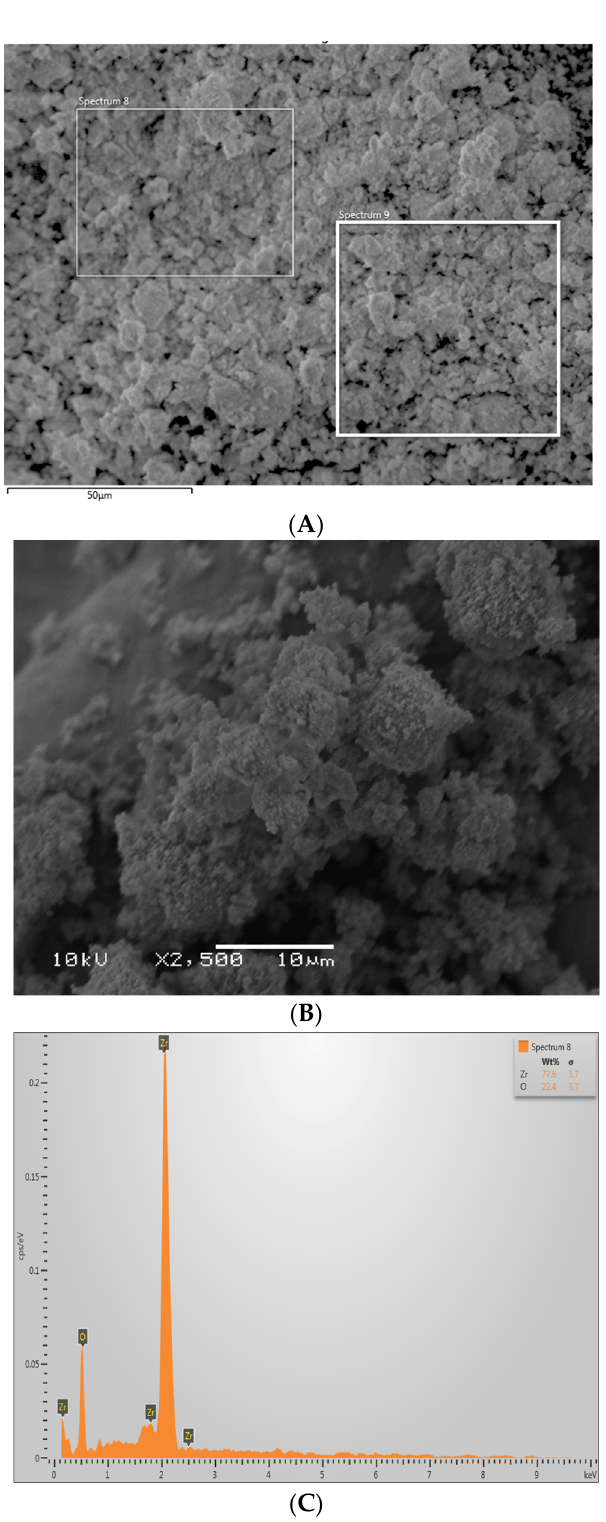
Figure 2. High magnification ( A , B ) SEM image of the nano-zirconium oxide (ZrO 2 ) particles. The ZrO 2 powder showed agglomerated particles of irregularly sized crystals around 500 nm. ( C ) Representative EDX graph showing high percentage of Zr and oxygen